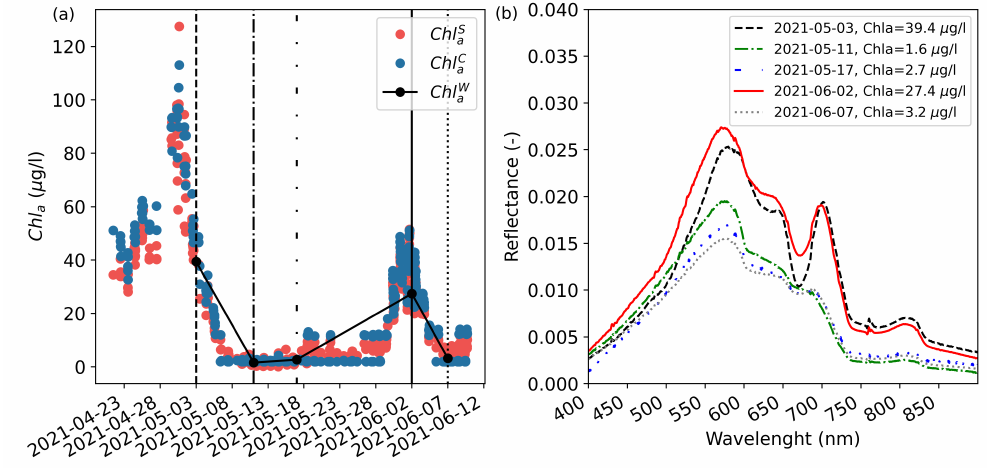
Figure 8. Zoom of Figure 7 between 2021-04-23 and 2021-06-12 ( a ) and reflectance spectra with corresponding Chl a concentrations retrieved with the water sampling points ( b ).